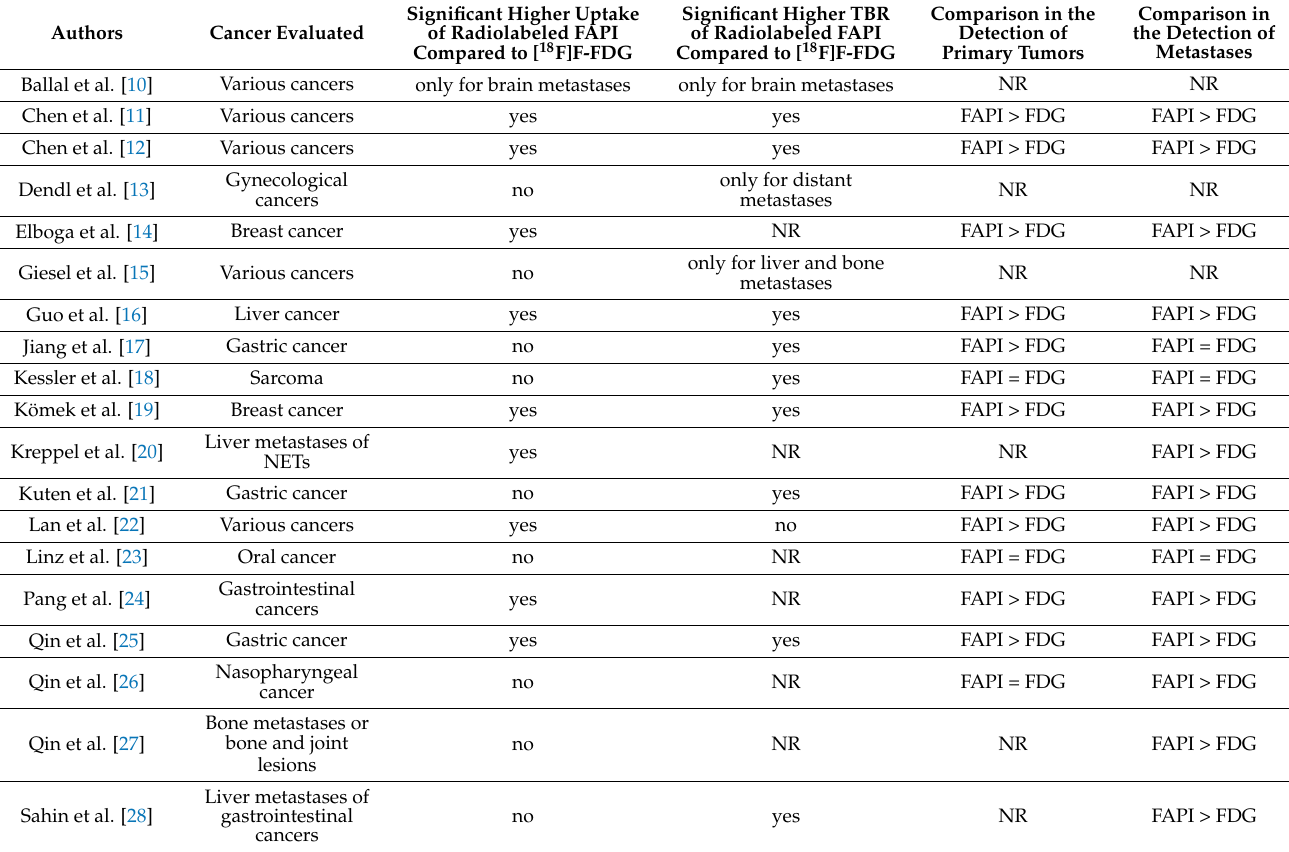
Table 3. Main results of the included studies about the comparison among [ 18 F]F-FDG and FAPI